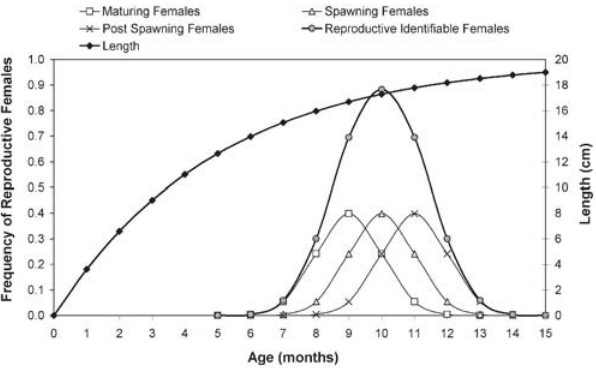
Fig. 1. Computer simulation of a growing age-group with temporal relative frequency at three different reproductive stages (maturing, spawning, post-spawning). For simplicity, each maturity stage has a standard deviation of one month and is one month apart. In this simulation L at age 10, when most of the females are identified as